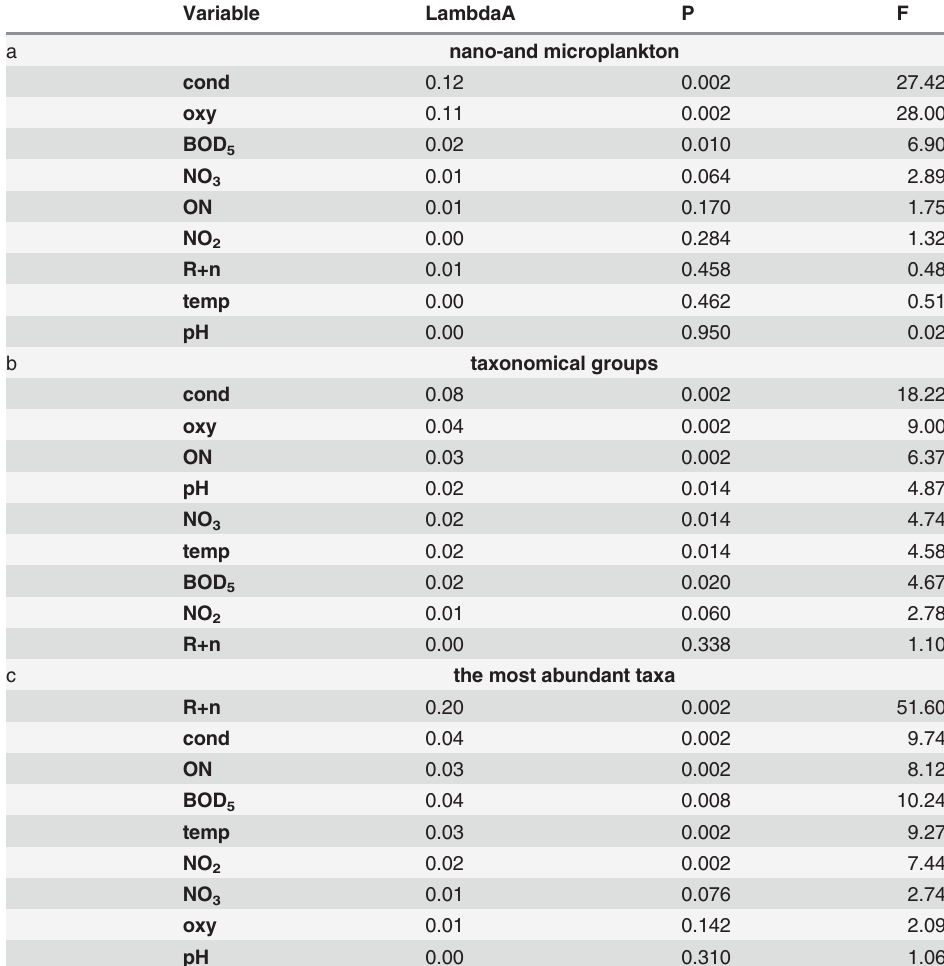
Table 3. Forward selection results of Monte Carlo test of relationships between a-phytoplankton size fractions, b-taxonomical groups, c-the most abundant taxa and selected environmental factors inde- pendent from restoration